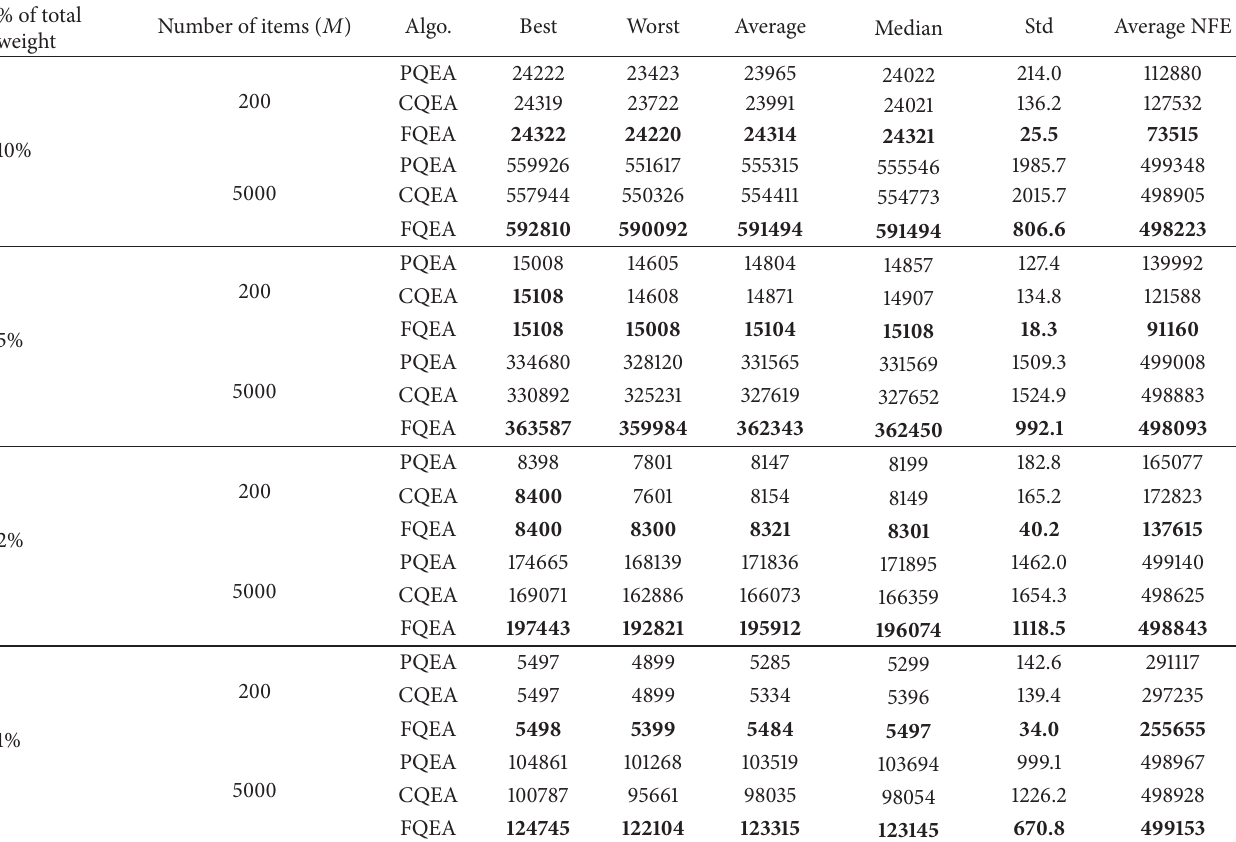
Table 4: Comparative study between PQEA, CQEA, and FQEA using statistical results on 0-1 knapsack problem with multiple strongly correlated data